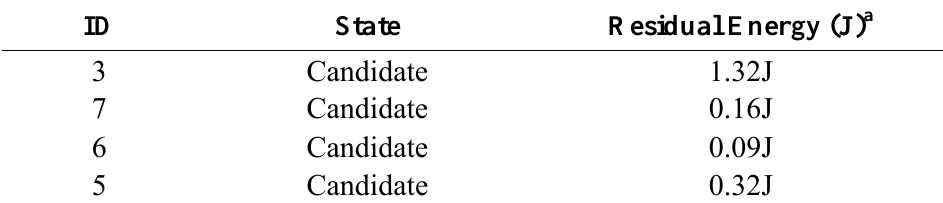
Table 2. Node 4’s Neighborhood